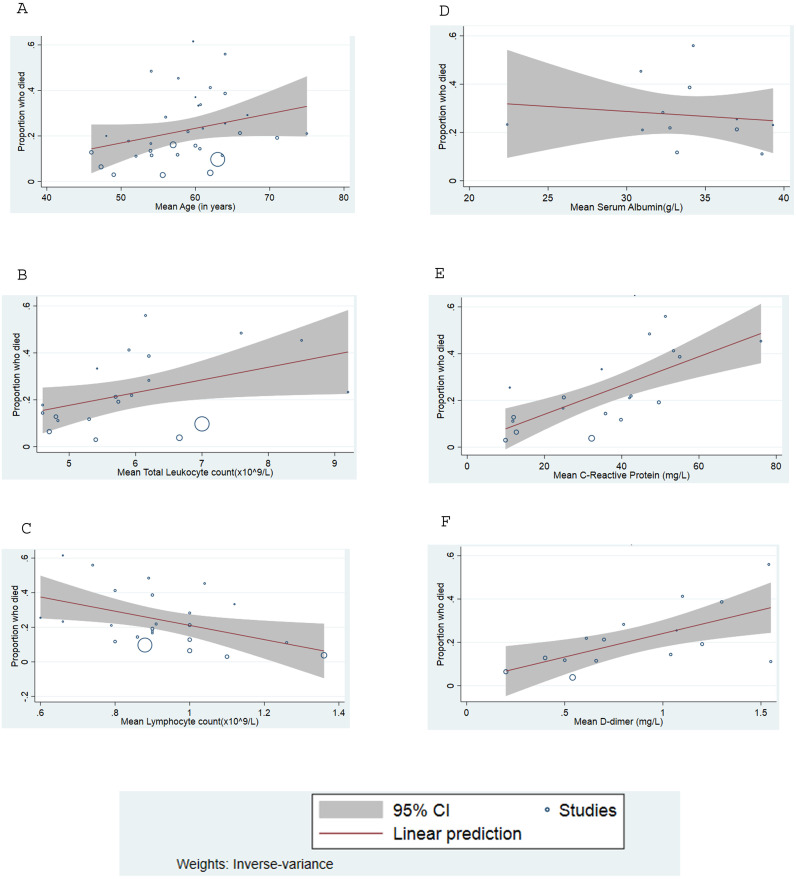
Meta-regression plot showing the proportion increase in mortality among COVID-19 patients regressed against (A) mean age. (B) mean leukocyte count. (C) mean lymphocyte count. (D) mean serum albumin. (E) mean C-reactive protein. (F) mean D-dimer.